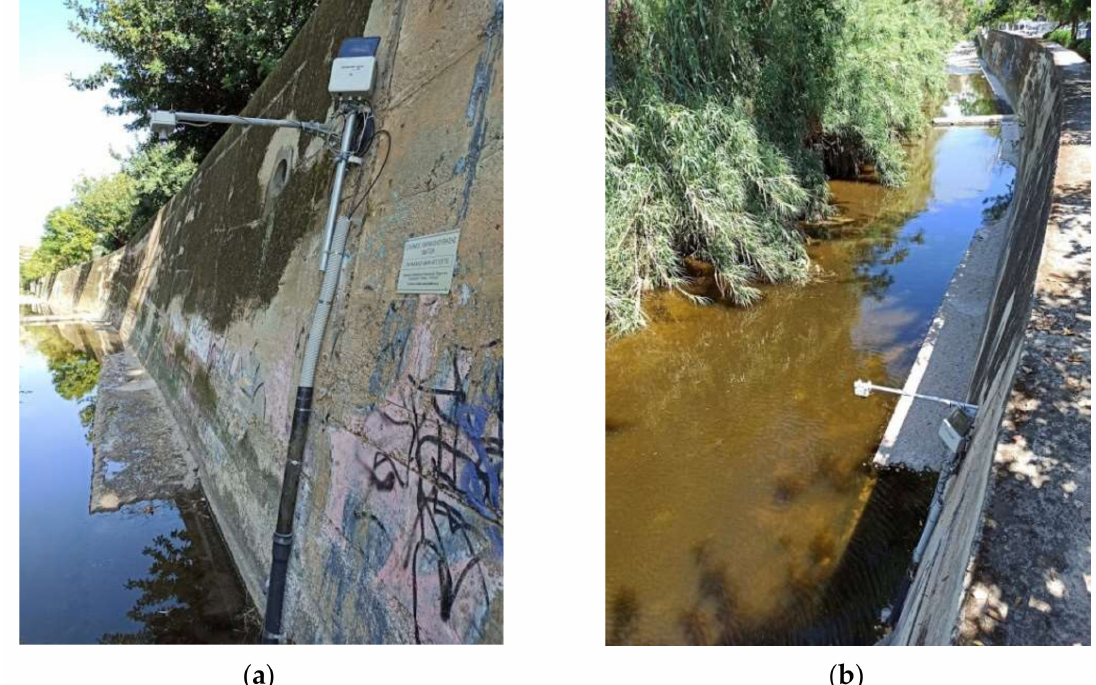
Figure 2. Two views ( a,b ) of the installation of the Hellenic Centre for Marine Research (HCMR) multiparameter sonde AT500 (including the pressure transducer) within the pipe attached to the wall and the ultrasonic sensor at the edge of the mounting bracket attached to the wall for water stage monitoring at the Pikordafni stream in the Attica